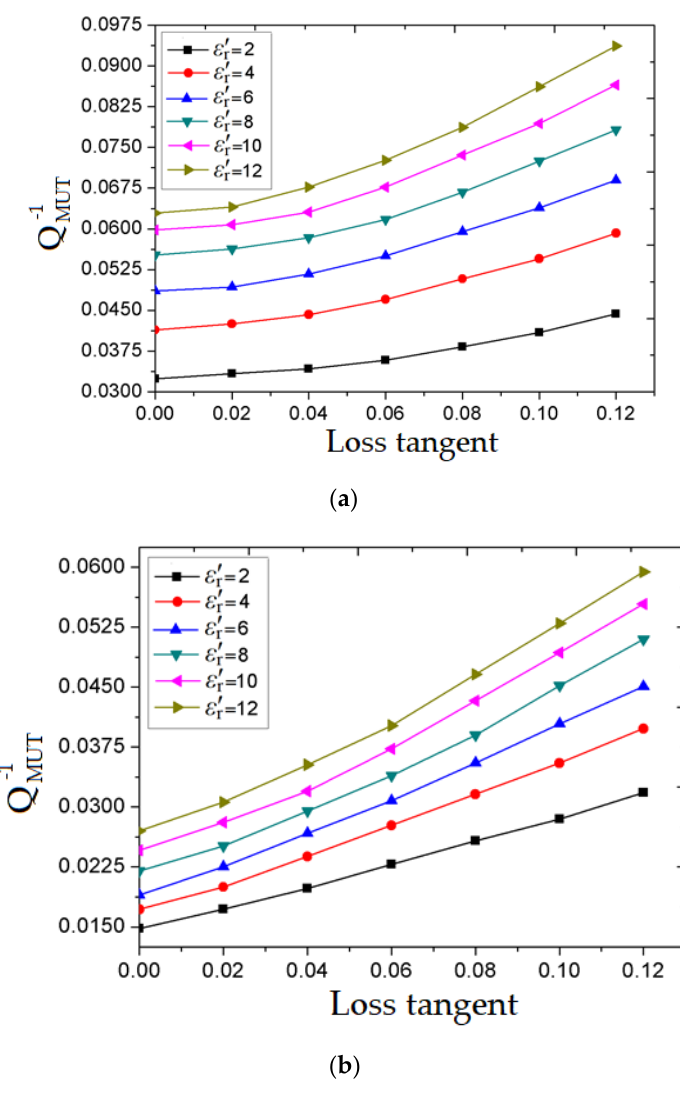
Figure 8. Inverse of Q-factor in terms of tan δ for various values of ε ʹ r , depending on resonant frequency: ( a ) f r,1 ; ( b ) f ʹ r,1.